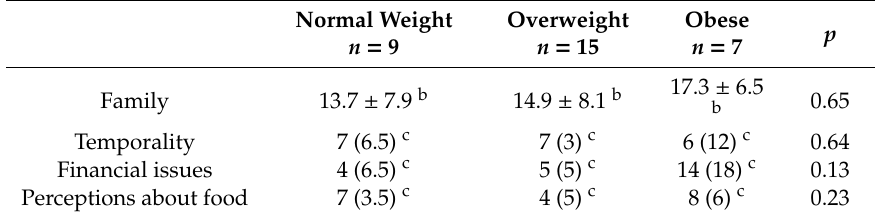
Table 4. Comparisons between the repetitions a of themes mentioned by the women according to weight